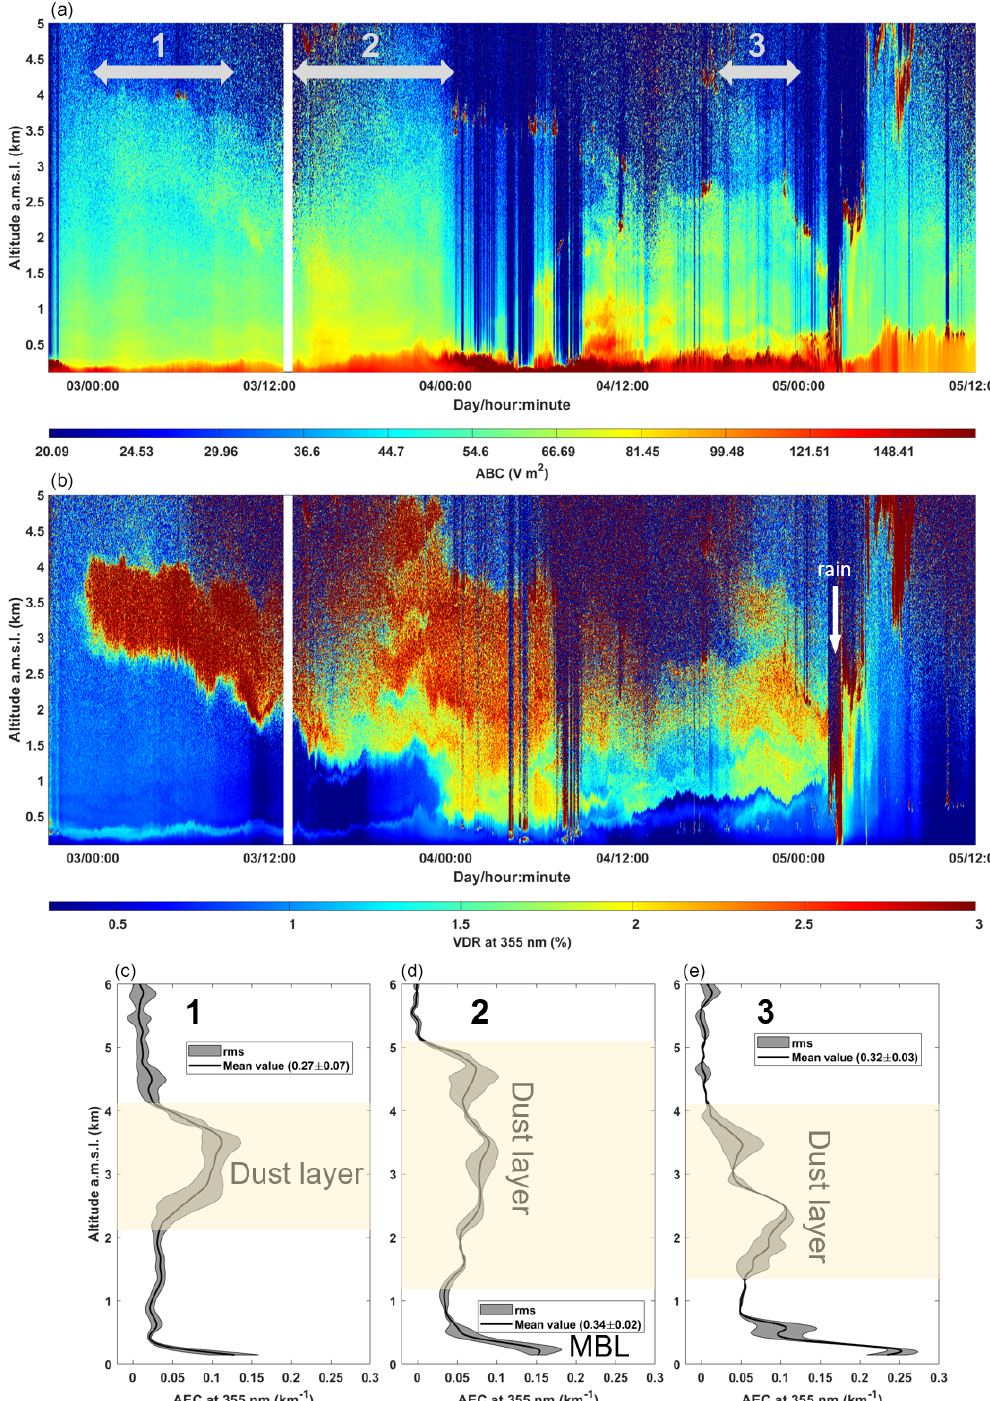
Figure 3. On-board lidar-derived (a) apparent backscatter coefficient (ABC); (b) temporal evolution of the lidar-derived volume depolariza- tion ratio (VDR) (in LT), where the dust plume is highlighted for values higher than ∼ 1.7 (yellow to red colours) and rain is shown by values higher than 3 (indicated by the white arrow); and (c) vertical profiles of the aerosol extinction coefficient in cloud-free conditions integrated over three periods denoted by 1, 2, and 3 in (a) along the dust plume event (c, d, e) . The grey shade represents the root-mean-square (rms) variability along the time of the measurement. The dust layer is highlighted on the profiles. The mean aerosol optical thickness is given in the boxed legend with its temporal variability (1 σ ). The location of the marine boundary layer (MBL) is also